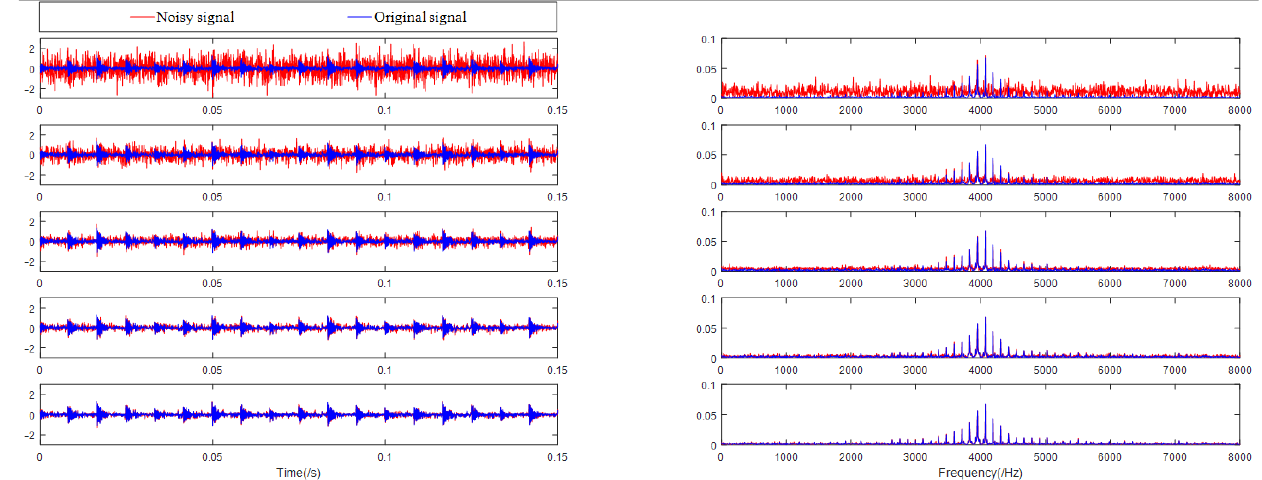
Figure 11. Time domain and spectrum of the noisy signal and the simulated signal (SNR = − 10 dB, −5 dB, 0 dB, 5 dB and 10 dB) .